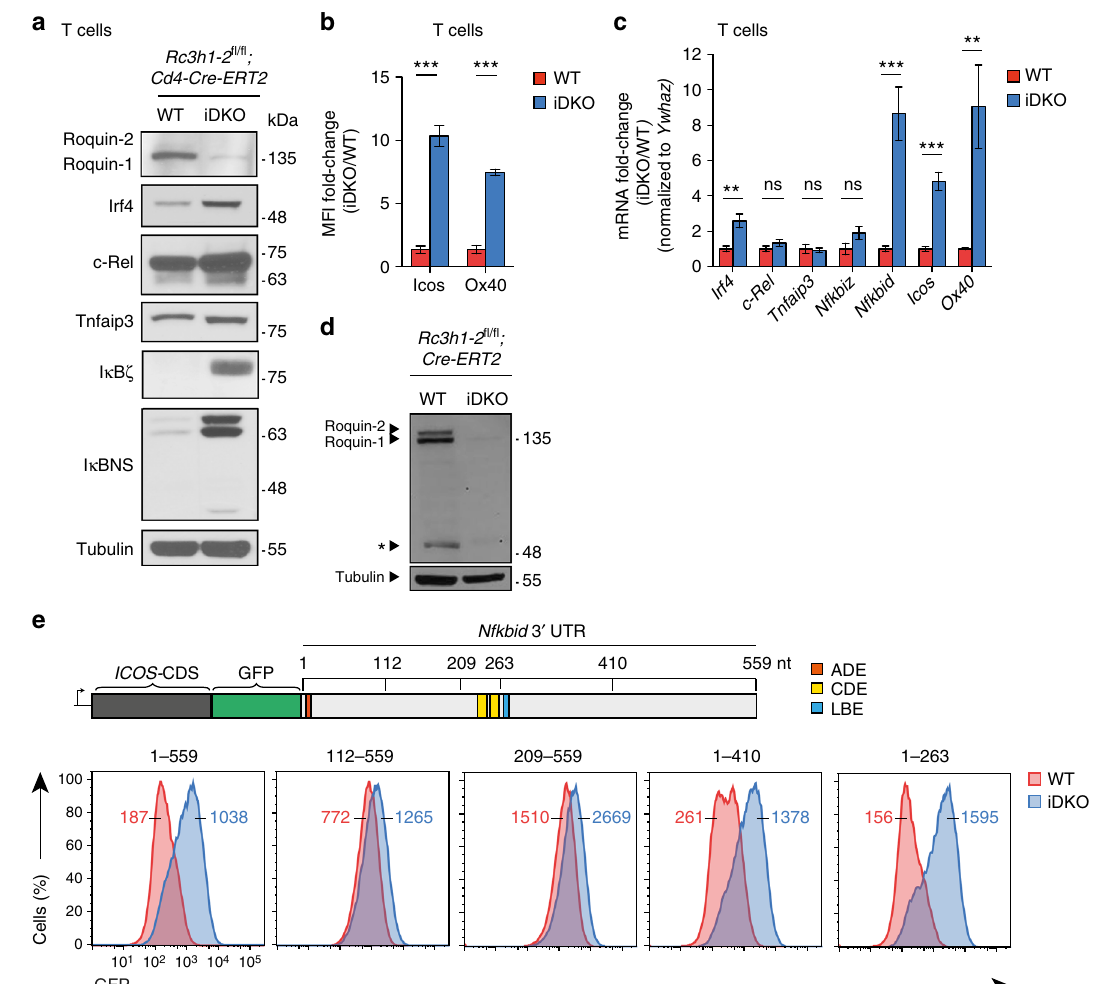
Fig. 2 Nfkbid is strongly regulated by Roquin on the mRNA and protein level. a – c Immunoblot ( a ), fl ow cytometry ( b ) and quantitative RT-PCR ( c ) analysis of previously described Roquin targets in CD4 + T cells derived from Rc3h1-2 fl / fl ; Cd4 - Cre-ERT2 (iDKO) mice treated in vitro with 4 ′ OH-tamoxifen. As wild- type (WT) controls either T cells from Rc3h1-2 + / + ; Cd4 - Cre-ERT2 (WT) mice were treated in vitro with 4 ′ OH-tamoxifen or T cells from Rc3h1-2 fl / fl ; Cd4 - Cre-ERT2 mice were left untreated. d Immunoblot analysis of Roquin-1 and Roquin-2 proteins before and after 4 ’ OH-tamoxifen treatment of MEF cells that contained Rc3h1 and Rc3h2 alleles with loxP- fl anked exons and a Cre-ERT2 transgene. e Flow cytometry analysis of GFP in Rc3h1 – 2 fl / fl , Cre-ERT2 MEF cells retrovirally transduced with a reporter construct encoding GFP and human ICOS coding sequence ( ICOS – CDS) followed by the full length Nfkbid 3 ′ - UTR (1 – 559) harboring two CDE, one ADE and one LBE element or truncated versions (scheme) of the 3 ' -UTR, either treated with 4 ′ OH-tamoxifen (iDKO) or left untreated (WT). Statistical signi fi cance was calculated by unpaired two-tailed Student ’ s t test ( b , c ); ns = not signi fi cant; *** p < 0.001, ** p < 0.01. Error bars indicate mean ± SEM. Data are representative of three ( a , b , d , e ) and seven ( c ) independent